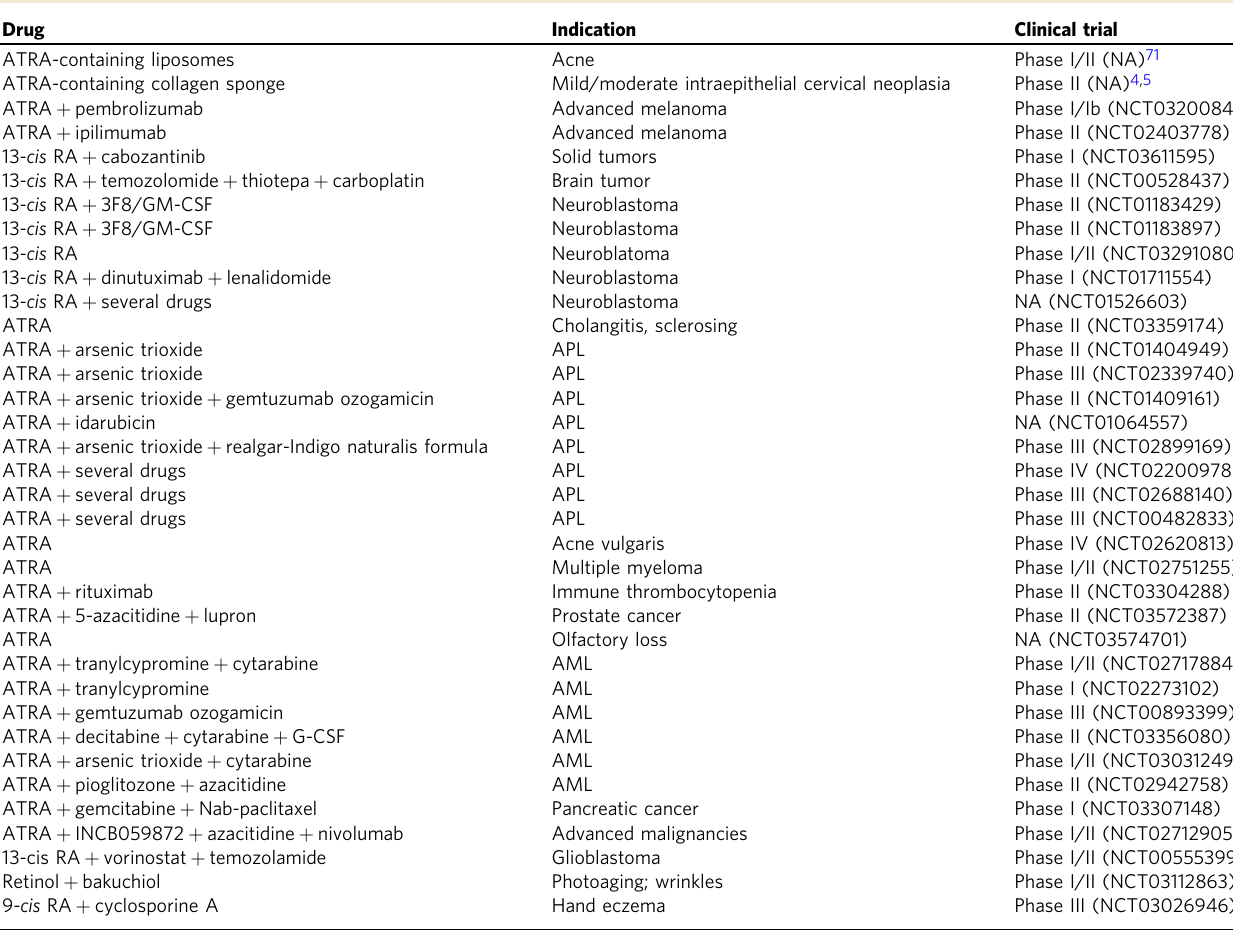
Table 1 RA formulations tested in past and ongoing clinical trials. Drug Indication ATRA-containing liposomes ATRA-containing collagen